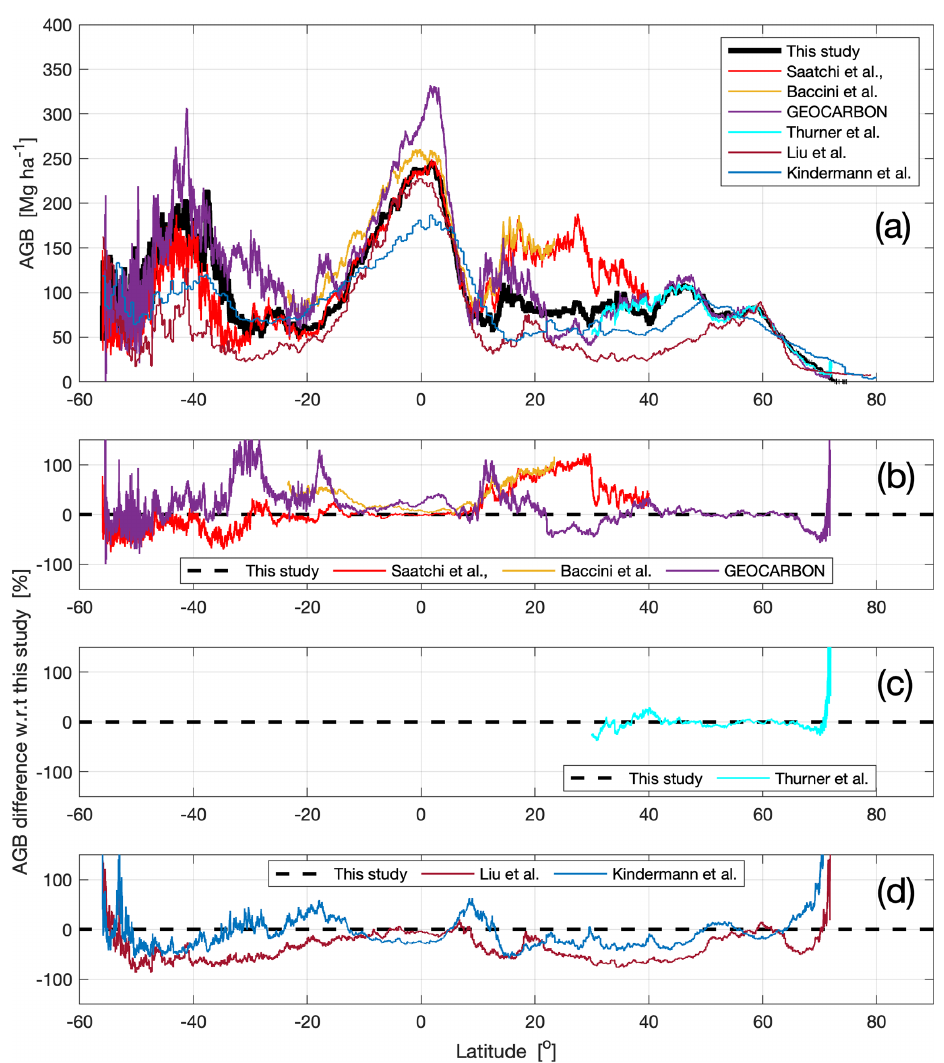
Figure 10. Profiles of average AGB along latitude for each dataset listed in Table 3 (a) , together with the corresponding relative difference between the latitudinal AGB derived from the other datasets and this study (b–d) , expressed in percentage values relative to our